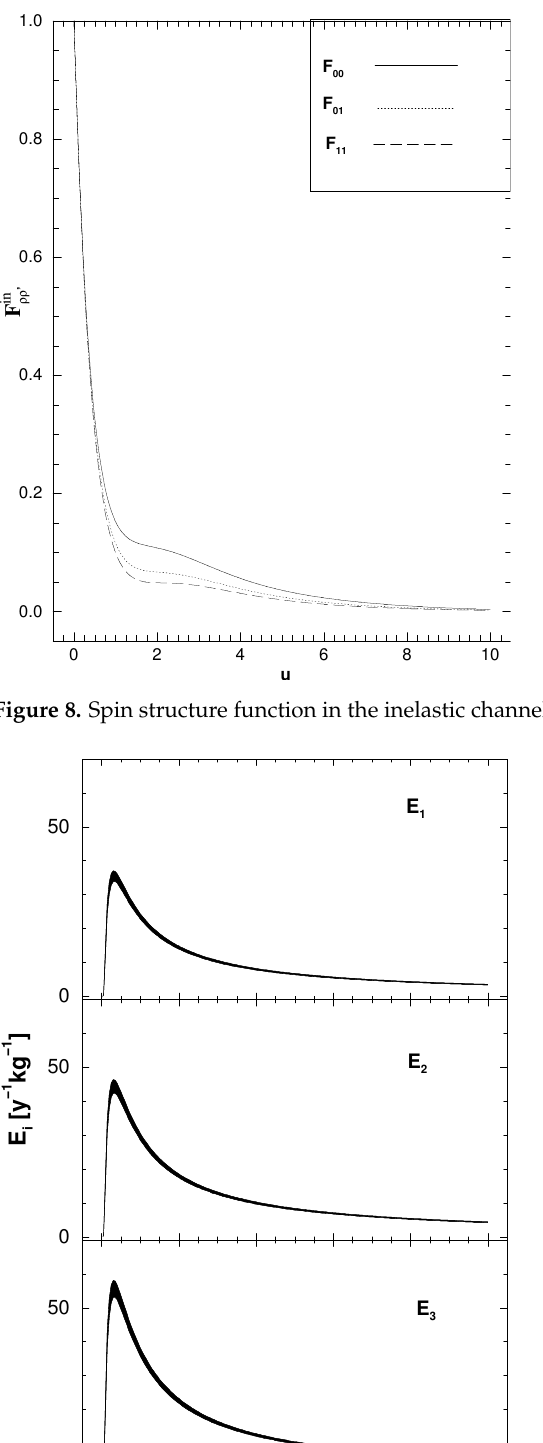
5/2 + for 23 Na. The →